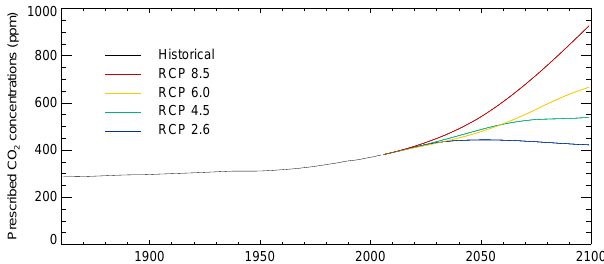
Figure 2. Atmospheric CO 2 concentrations in the representative concentration pathways (RCPs) as prescribed as inputs to the HadGEM2-ES simulations in this